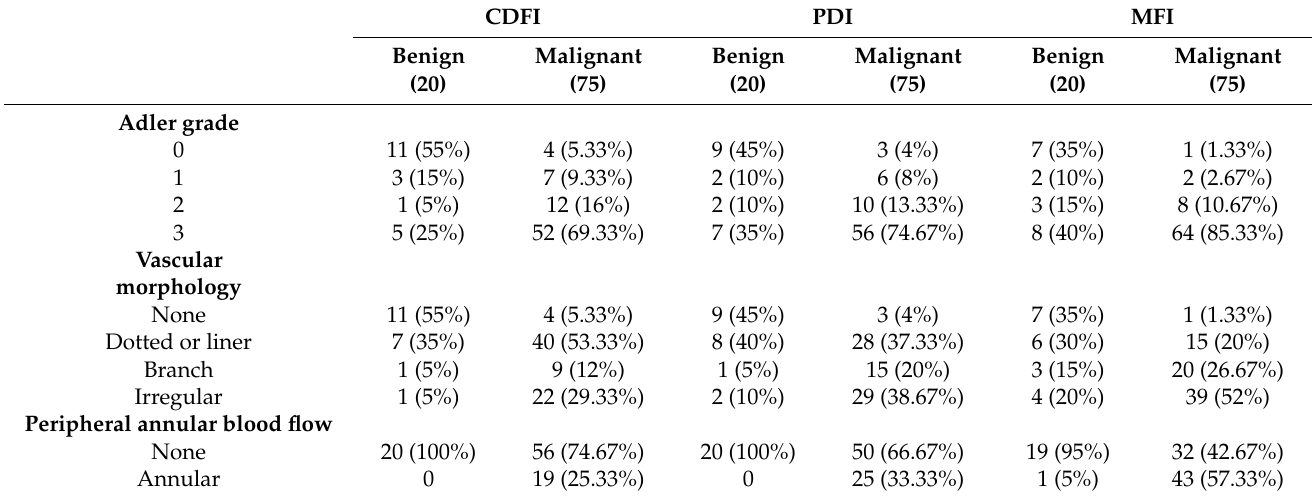
Table 4. Blood flow characteristics of benign and malignant renal tumors > 4 cm evaluated by CDFI, PDI and MFI